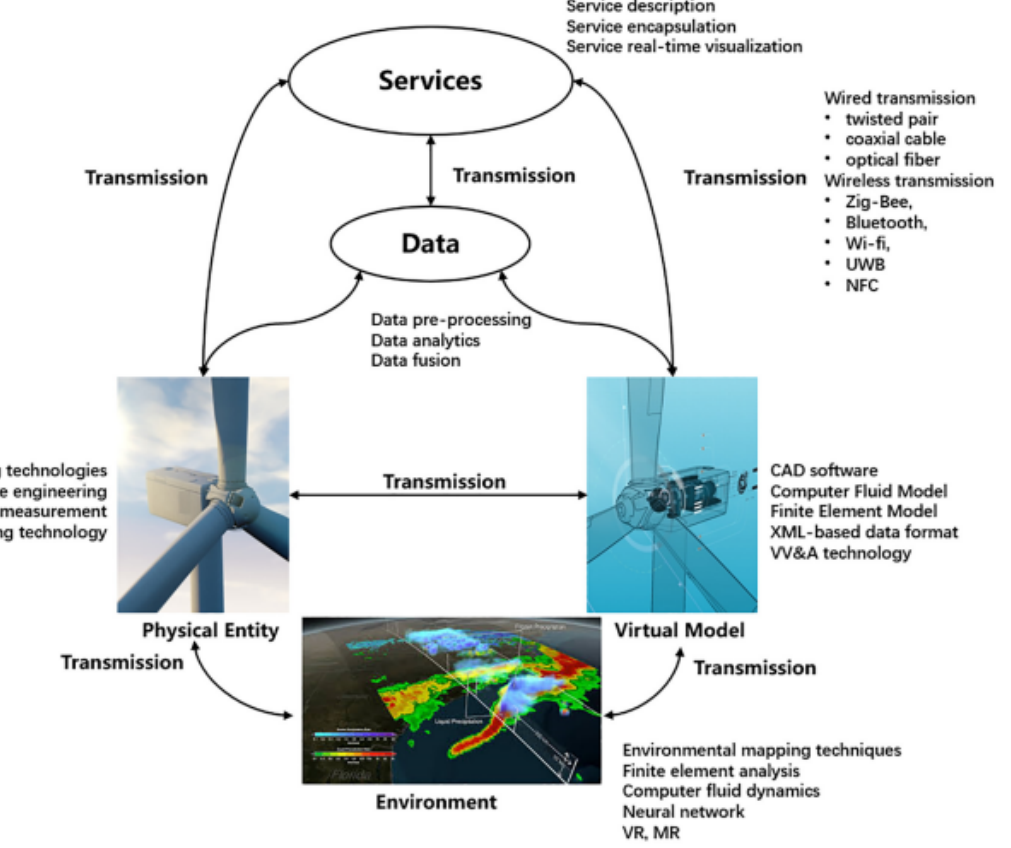
Figure 20. Variety of enabling DT technologies [53].